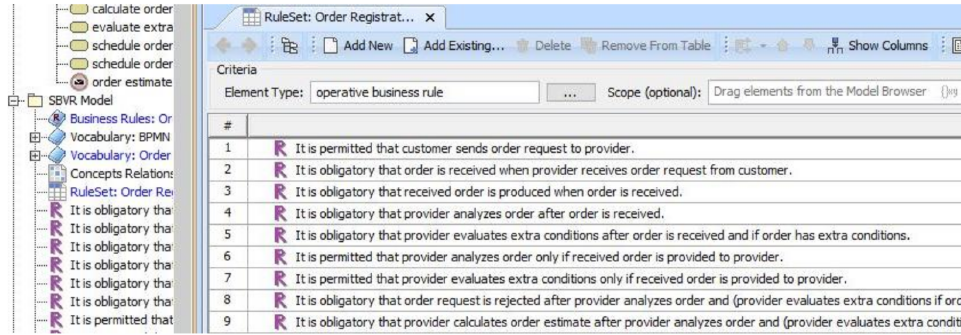
Figure 4. MagicDraw table for representing SBVR business rules (including process